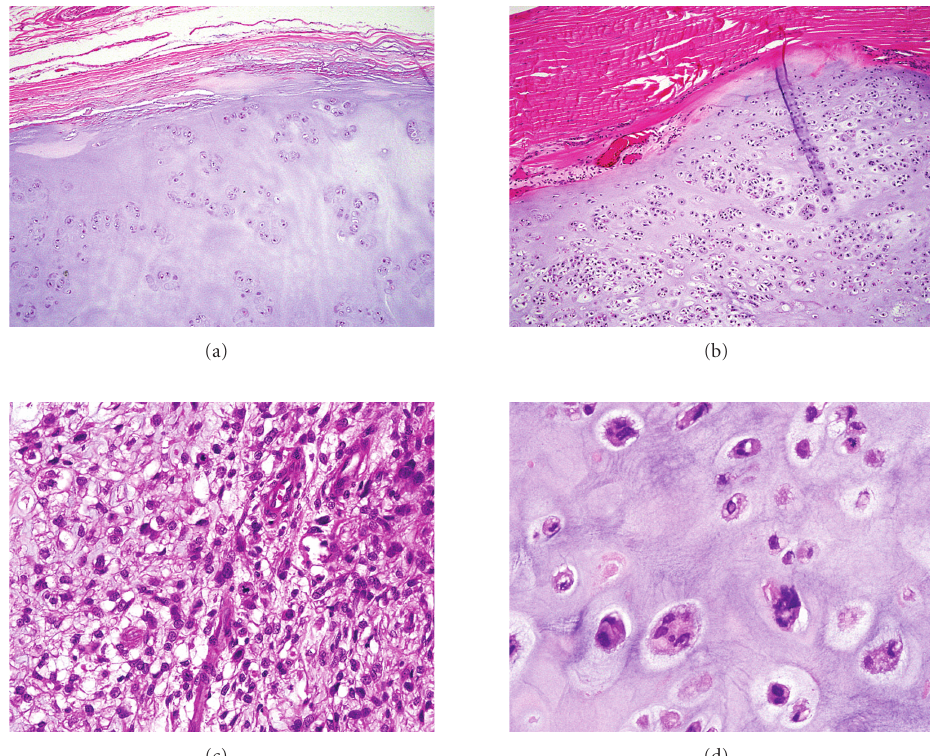
Figure 4: (a) Grade 1 CHS with chondroid matrix and low cellularity. Note the soft tissue extension. (b) Grade 2 CHS with increased cellularity and soft tissue extension. (c) Grade 3 CHS with more increased cellularity and cellular atypia. (d) Pleomorphic tumor cells and frequent multinucleated cells in grade 3 CHS.